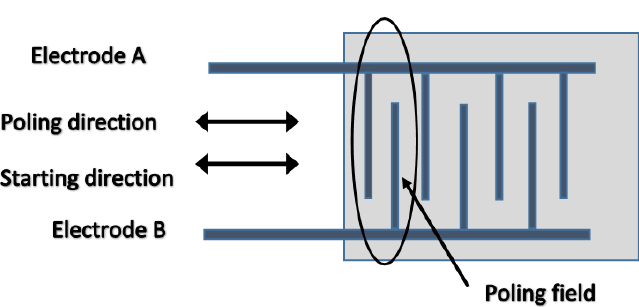
Figure 10. Interdigital electrode arrangement